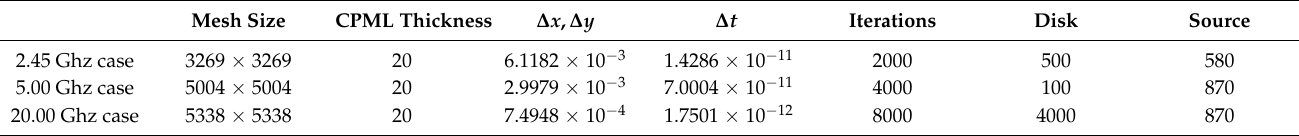
Table 9. Experiments setup for the parabolic reflector scenery. Iterations refer to the number of time steps performed. Disk, to the number of iterations when the information has to be transferred to the CPU and saved to the disk. Source, refers to the number of operations when the source is turned